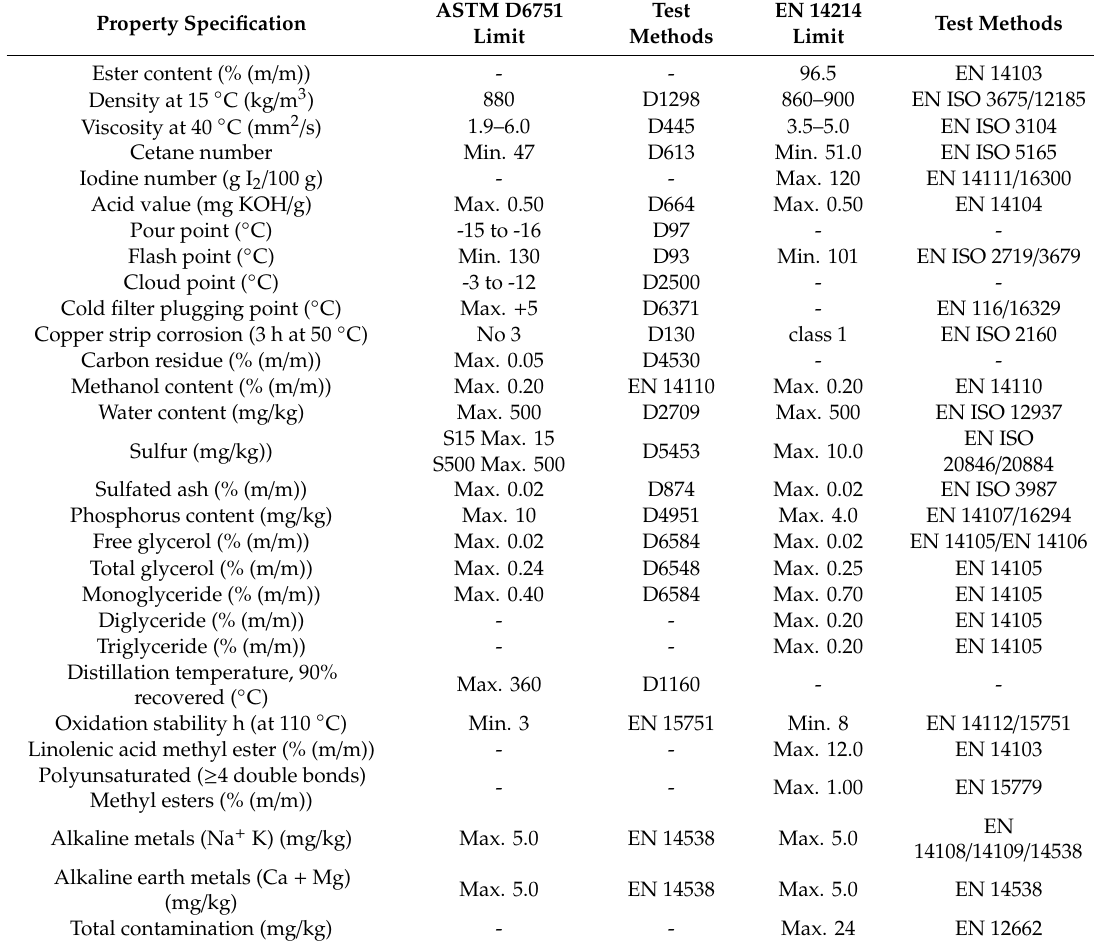
Table 9. ASTM D6751 and EN 14214 specifications of biodiesel fuels (B 100)